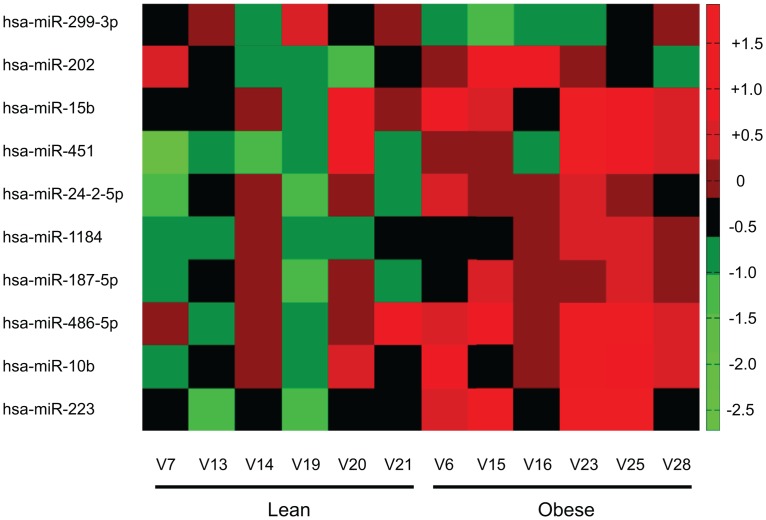
Heatmap of miRNA expression for those with a significant difference between groups.The heatmap is organized by group (lean or obese) on x-axis and increasing significance between groups from top to bottom on the y-axis. Red indicates an increase and green/black a decreased relative expression per sample (n = 6 per group).